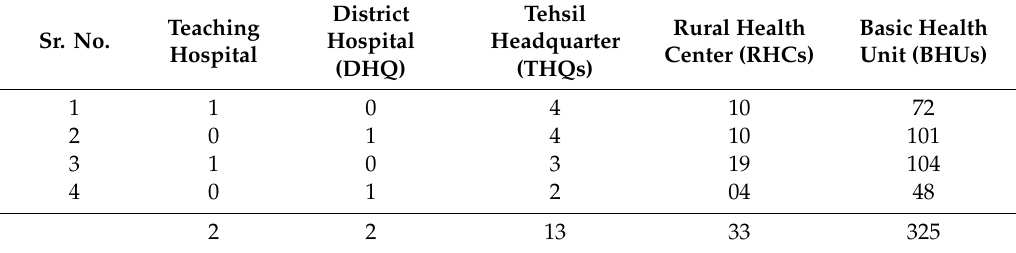
Table 2. Hospitals in